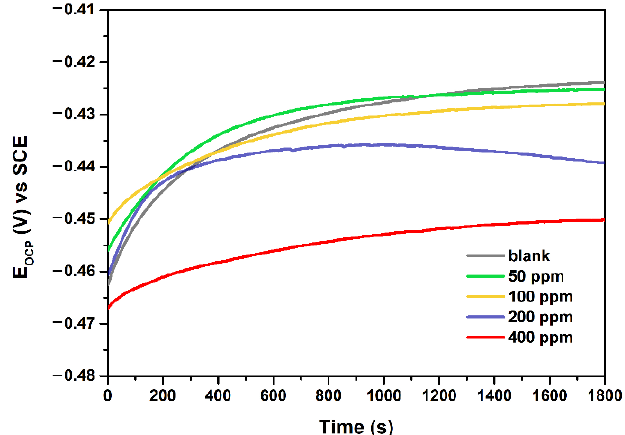
Figure 3. Variation of OCP with increasing time for Q235 steel in 1 M HCl solution in the absence and presence of different concentrations of NCDs. and presence of different concentrations of